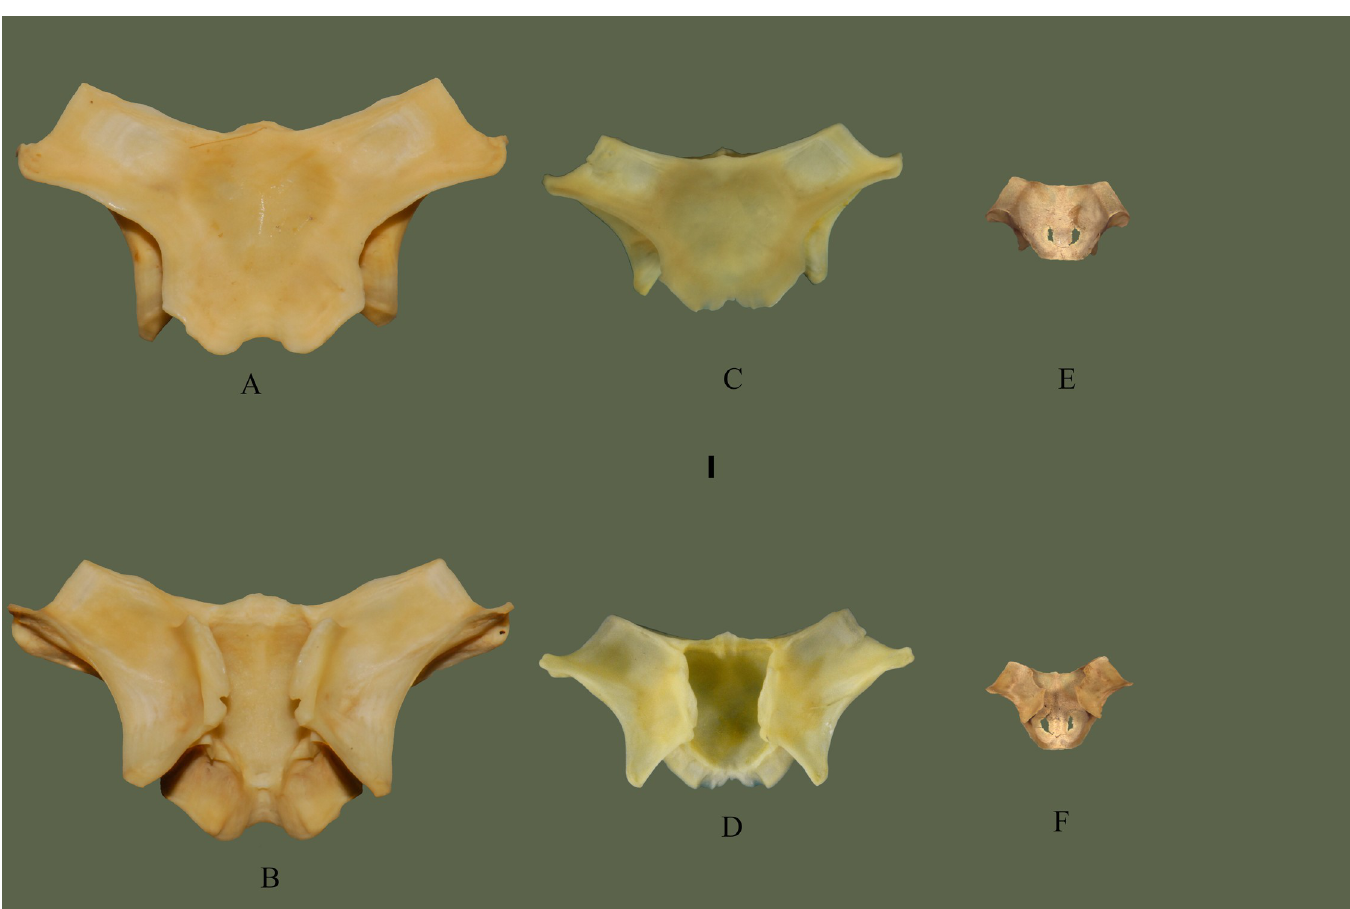
Fig 24. Parietal ontogeny. ETVP 3295 in dorsal (A) and ventral (B); ETVP 3293 in dorsal (C) and ventral (D); ETVP 3306 in dorsal (E) and ventral (F). Anterior is to the top of the page. Scale bar = 1